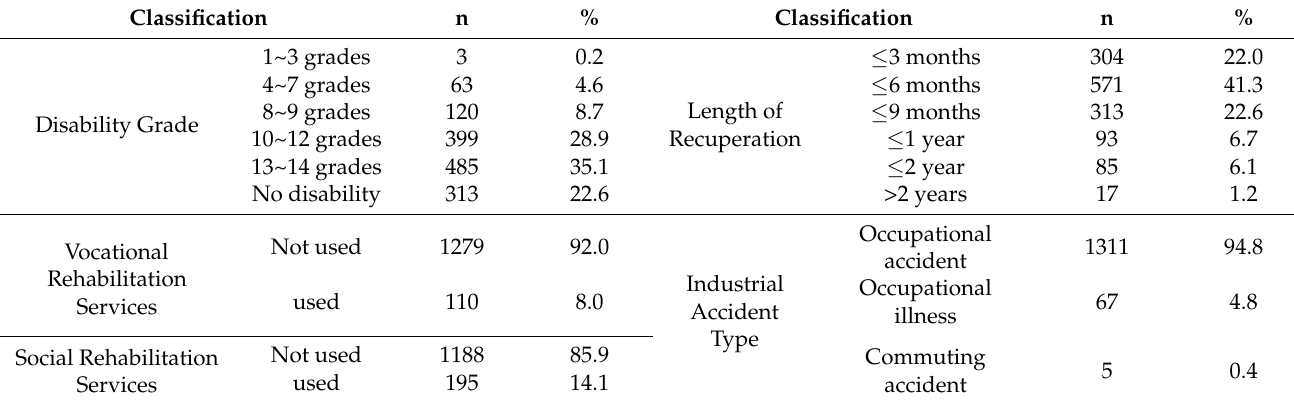
Table 4. The results of industrial accident-related frequency analysis.